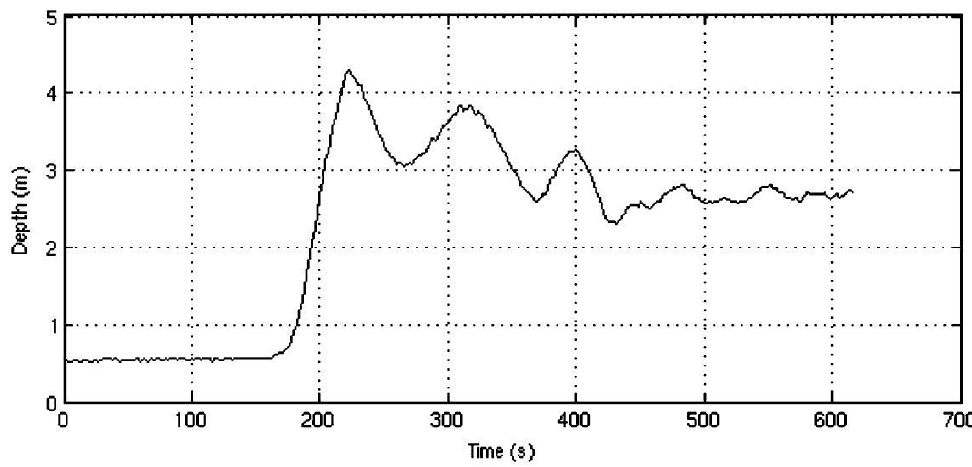
Figure 14. Depth response of hovering control via on-off type VBS of Seahorse AUV in [18], with the permission from IEEE, 2007.